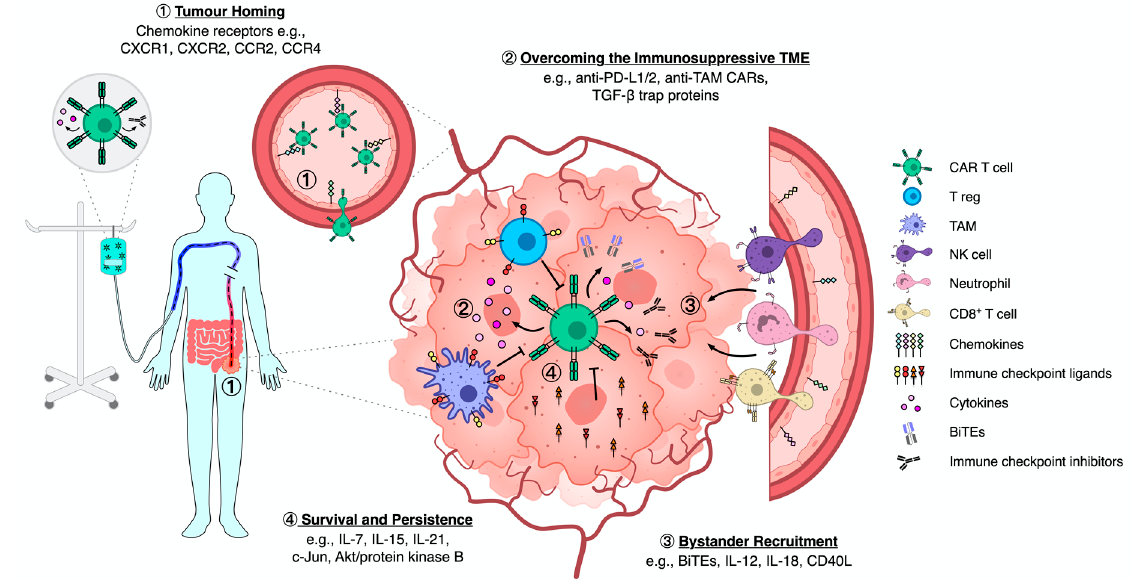
Figure 1. Schematic diagram outlining CAR T cells homing to and interacting within a solid tumours’ immunosuppressive TME. Examples of engineering strategies are listed within each numbered section. 1 (cid:13) Following IV infusion, engineered CAR T cells are dispersed throughout the total blood compartment of the patient with only a minority reaching the tumour vasculature for potential tissue homing. Upon entry into the tumour vasculature, CAR T cells are exposed to a plethora of soluble and endothelial-bound chemotactic molecules that mediate endothelial tethering, extravasation and interstitial migration into the TME. 2 (cid:13) Upon successful entry into the TME, CAR T cells face immunosuppressive barriers that circumvent anti-tumour efficacy. Cancer cells, as well as immune populations including TAMs and Tregs, express inhibitory molecules and secrete anti-inflammatory factors that promote immune evasion and tumour progression. Although surrounded by immunosuppressive cues, CAR T cells will constitutively produce and secrete the proteins they are engineered to do so; strategies used to counteract the immunosuppressive TME or promote anti-tumour efficacy include pro- inflammatory cytokines, BiTEs and immune checkpoint inhibitors. 3 (cid:13) Following sustained transduced protein production, particularly in the context of pro-inflammatory cytokines, bystander effector immune cells are recruited from both the peripheral blood and neighbouring stromal compartments towards the tumour. Upon performing anti-tumour immune mechanisms, the bystanders will produce further cytokines that self-perpetuates recruitment in a positive feedback loop. Aside from further recruitment, the ongoing cytokine production from engineered CAR T cells and engaged bystanders will promote repolarisation of the TME away from an immunosuppressive state. 4 (cid:13) CAR T cells can also be engineered to produce cytokines and intracellular signalling proteins that promote survival, persistence and, therefore, anti-tumour efficacy within the